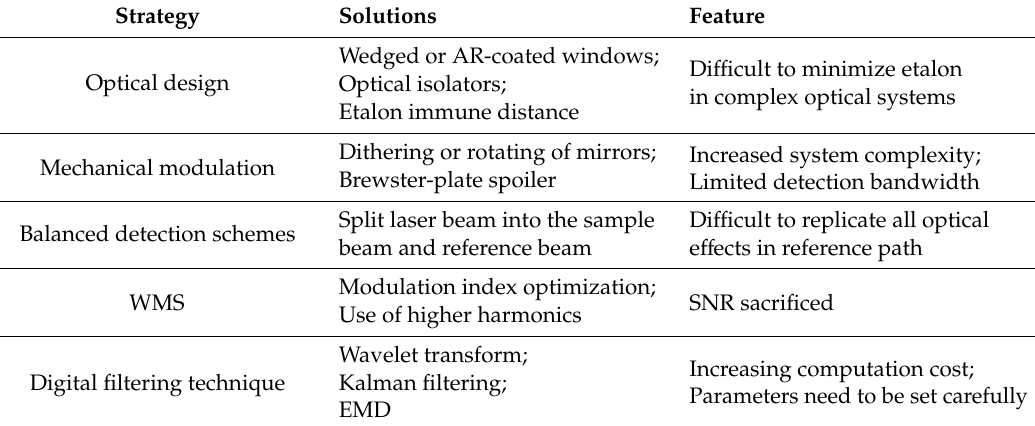
Table 3. Comparison of strategies to minimize interference fringe noise. AR: anti-reflective, EMD: empirical mode